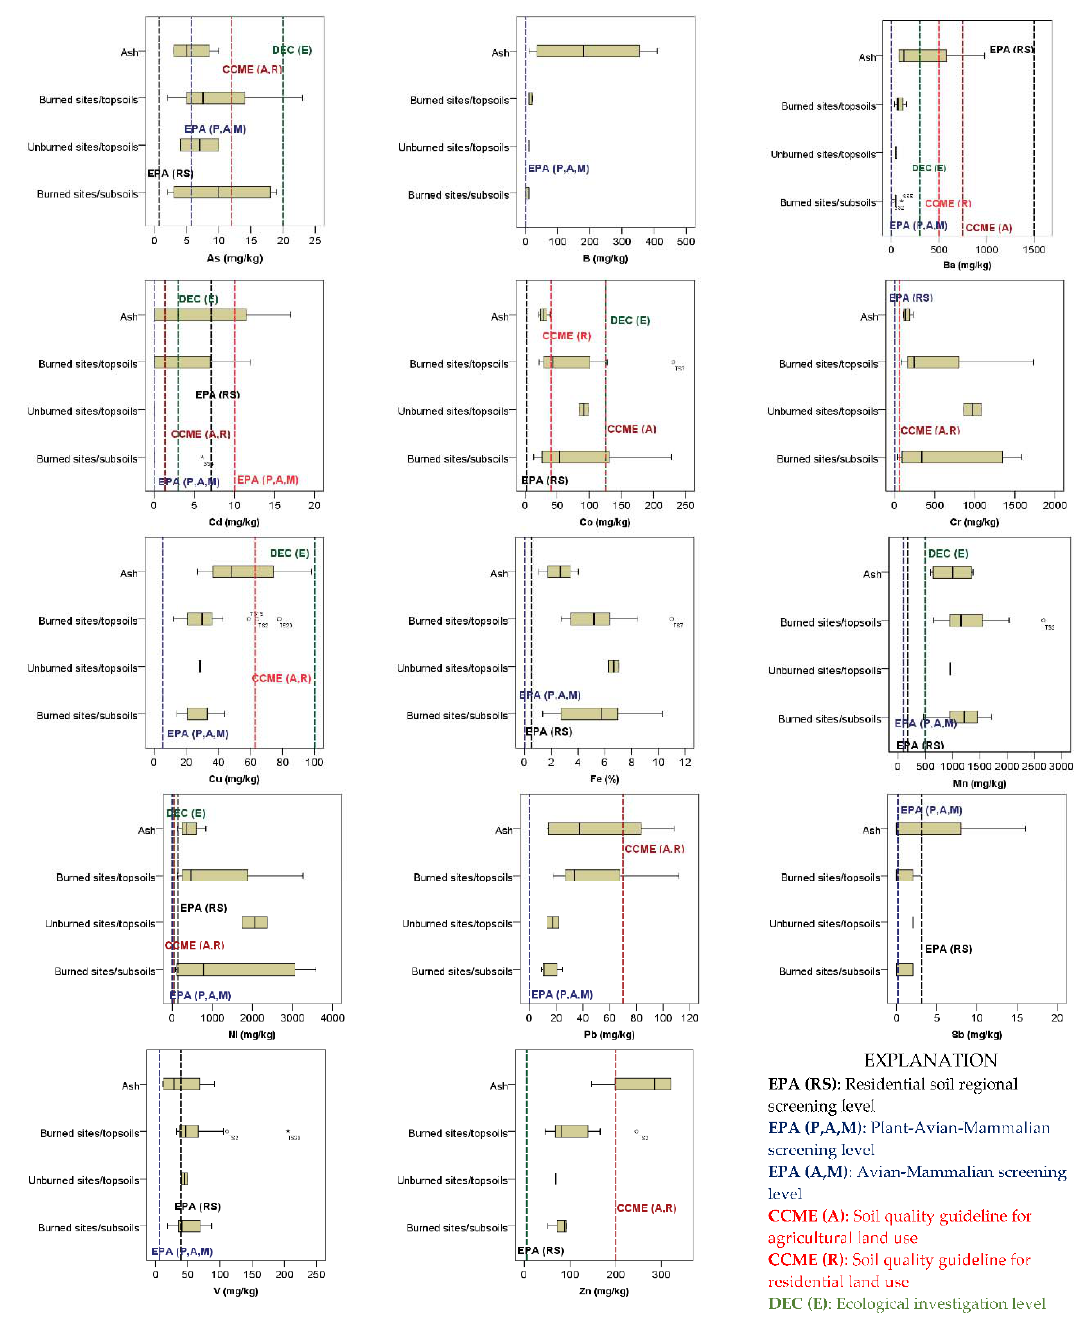
Figure 2. Boxplot comparing element concentrations to criteria given from the literature [35–37].